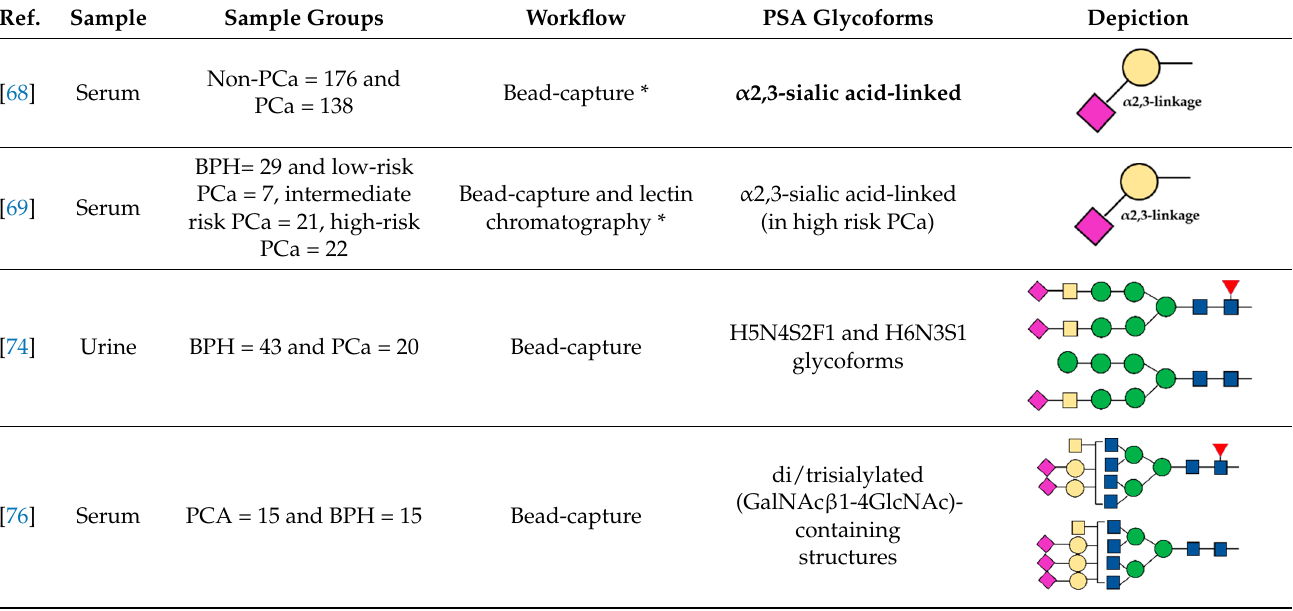
Table 5. Main differentially abundant glycoforms of PSA found increased in PCa. * indicates non-MS-based workflows. Plain text = discovery level; bold character = validation level. Bead capture = PSA immunopurification by anti-PSA microbeads.